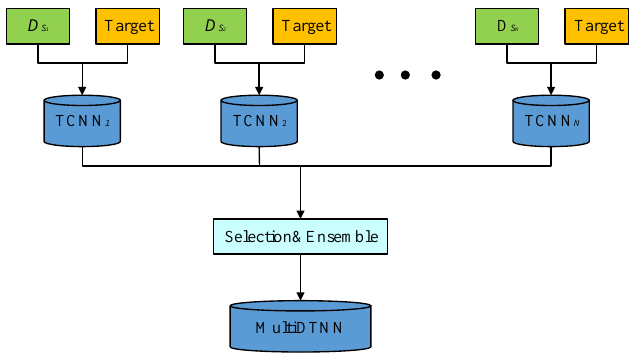
Figure 2. Framework of MultiDTNN.